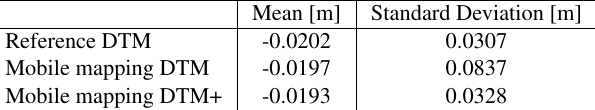
Table 2. Height difference between leveling measurements of manholes and the DTMs